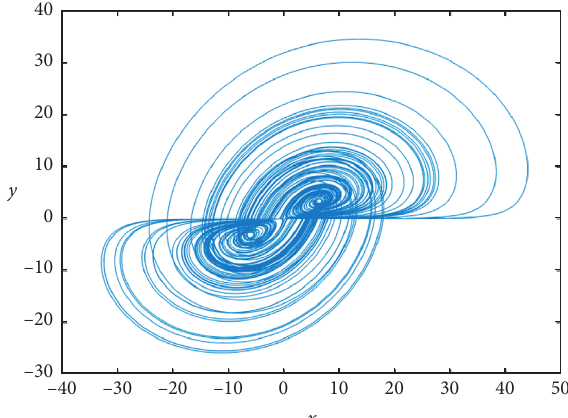
Figure 8: Dynamics of Lu et al.’s fractional-order system in (13)–(15) with the order α � 0 . 95, in context of x and y